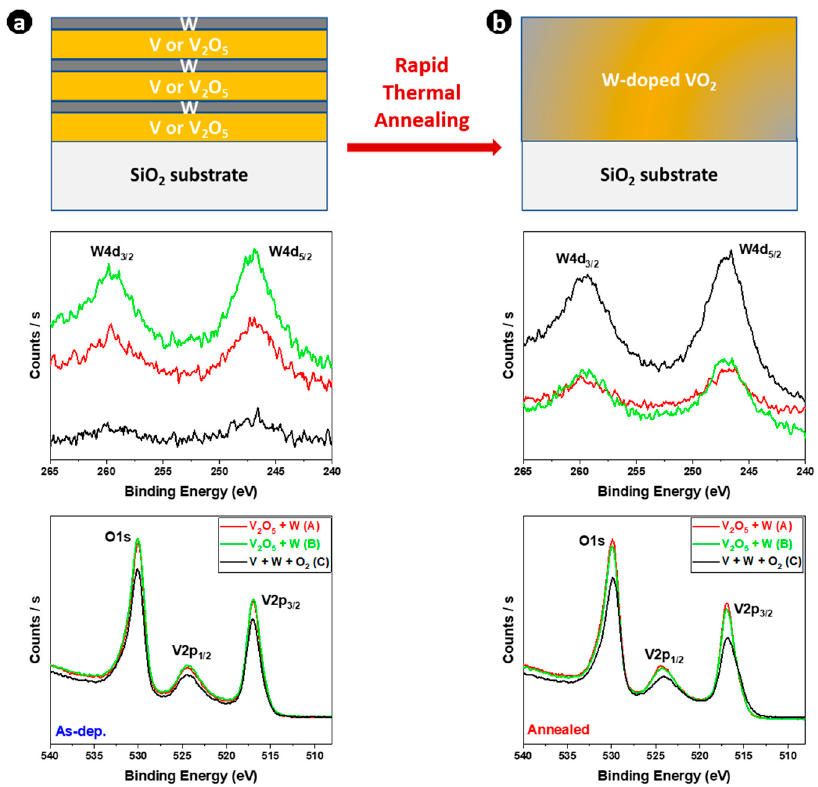
Figure 3. V 2p and W 4d core-level XPS spectra of ( a ) W-doped VO X as-deposited thin films, and ( b ) W-doped VO 2 thin films after rapid thermal annealing. The W peaks of W 4d 5/2 and W 4d 3/2 were located at 246.8 and 259.8 eV, respectively, reflecting the + 6 oxidation state of W ions in both thin films [11,12,41,44]. The V 2p core- level was split into two regions, V 2p 3/2 located at 516.9 eV and V 2p 1/2 located around 524 eV [45,46], with the O1s located at 530 eV. The intensity of vanadium and oxygen peaks is not the same for all films, especially when the two deposition precursors V/W (O 2 ) and V 2 O 5 /W are compared. Since the intensity of the tungsten peak differed from one sample to another, the W content differed. The presence of W can also be confirmed by its W 4f valence state [11]. The angle-resolved XPS spectra of W 4f core-levels at 23 and 68° of sample C are shown in Figure 2a after thermal annealing. Two strong peaks of W 4f core- level located at 34.7 eV and 36.9 eV were assigned to W 4f 7/2 and W 4f 5/2 , respectively. This revealed that W 6+ cations were present in W-doped VO 2 thin films in line with previous reported work [47], and confirmed the successful W-doping of VO 2 thin films. Further- more, the atomic concentrations of W were calculated based on the XPS spectra of V 3p and W 4f and the results of the quantification are shown in Figure 4b.